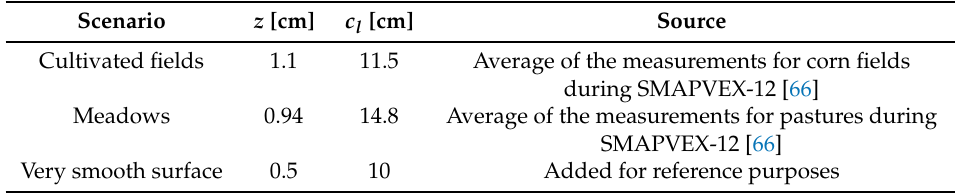
Table 3. The root mean square surface height ( z ) and the autocorrelation length ( c l ) for three surface roughness scenarios. These surface roughness scenarios were used to evaluate the impacts of the weather-related surface conditions and s S 1 on soil moisture